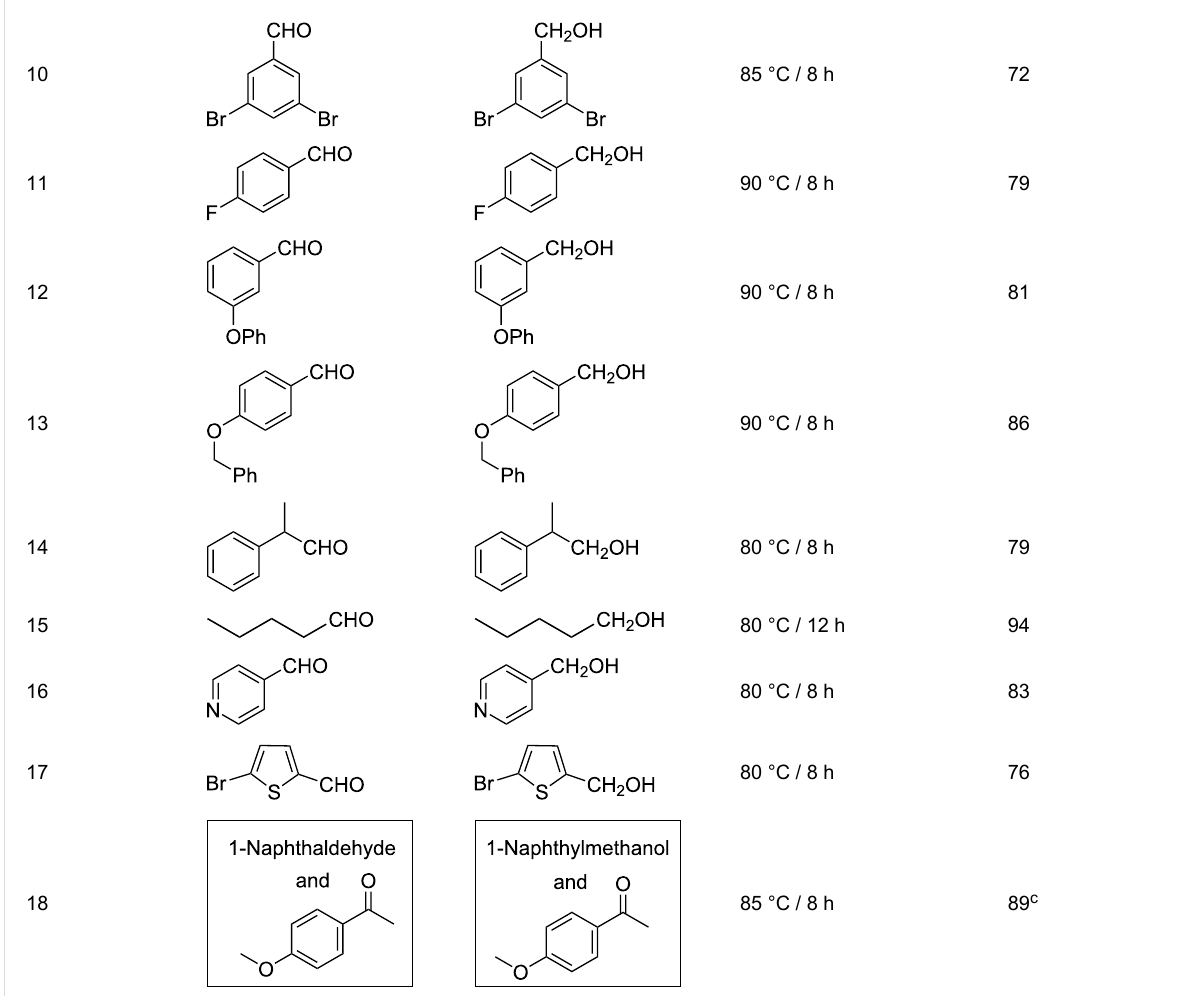
(Table 1, entry 12). The resin beads obtained after filtration from the reaction mixture could be reused for further hydrogen- ation reactions after washing with methanol and recharging with formic